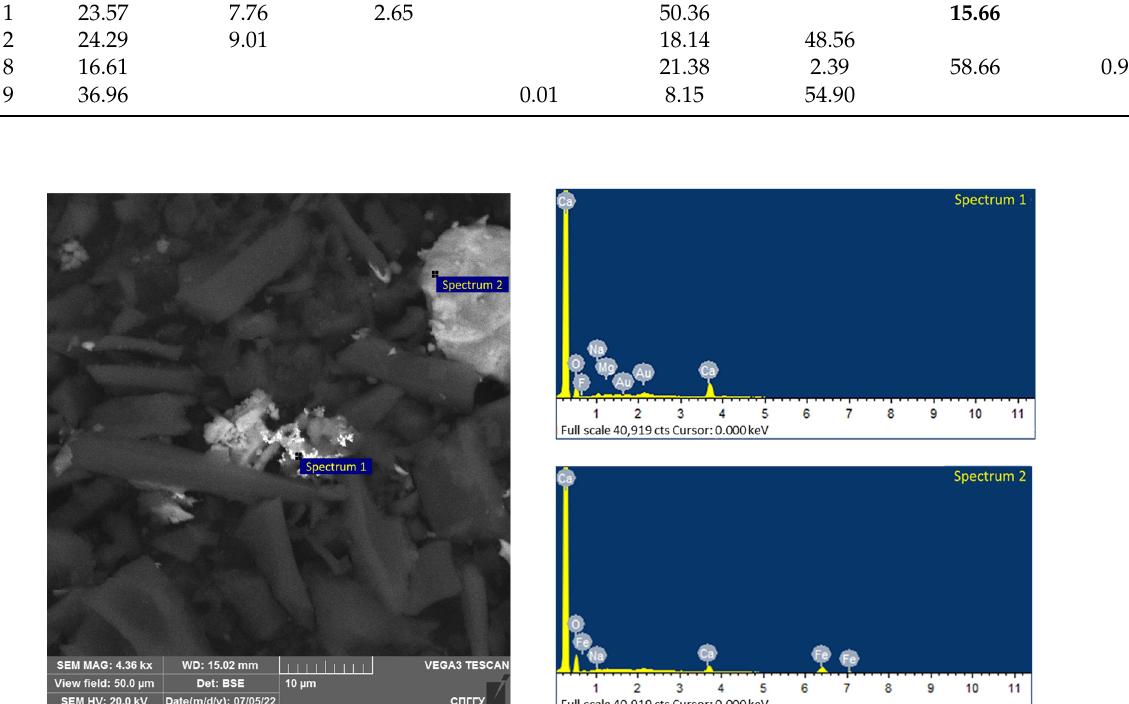
Figure 18. Results of the investigation of samples after microwave treatment with the addition of 5% magnetite.